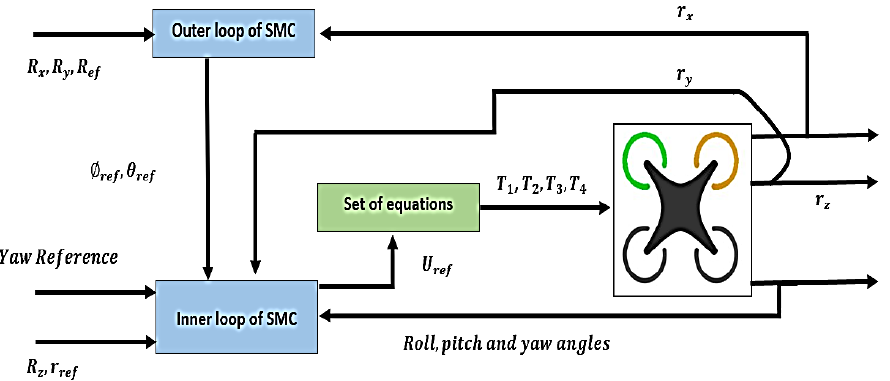
Figure 1. Conventional block diagram of SMC.